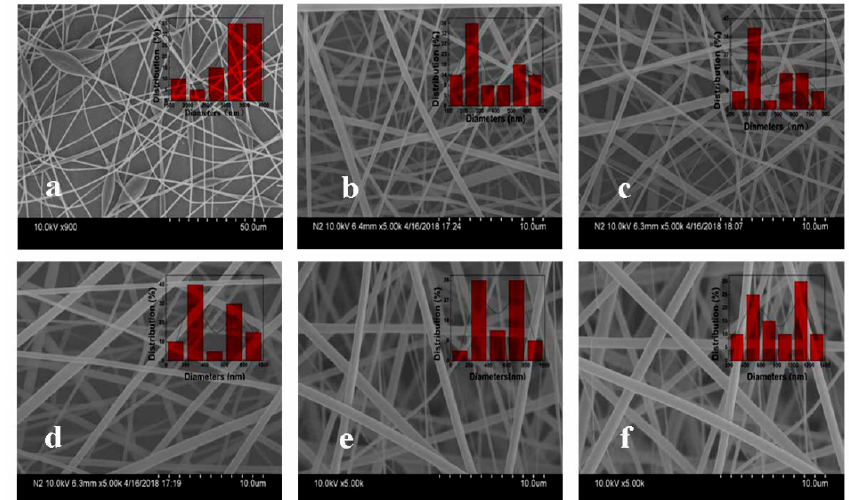
Figure 2. SEM micrographs and diameter distributions of the sc-PLA/PMMA nanofibers with sc -PLA contents of ( a ) 0 wt %, ( b ) 5 wt %, ( c ) 10 wt %, ( d ) 15 wt %, ( e ) 20 wt % and ( f ) 25 wt %.